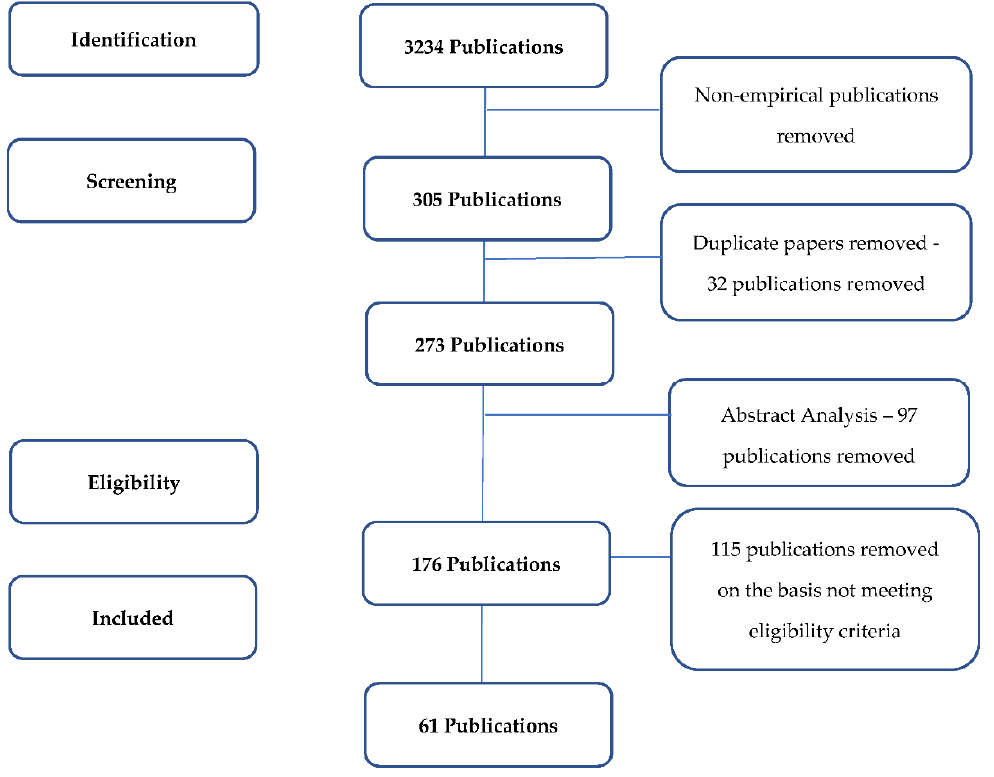
Figure 1. The flow chart of the systematic review methodology.